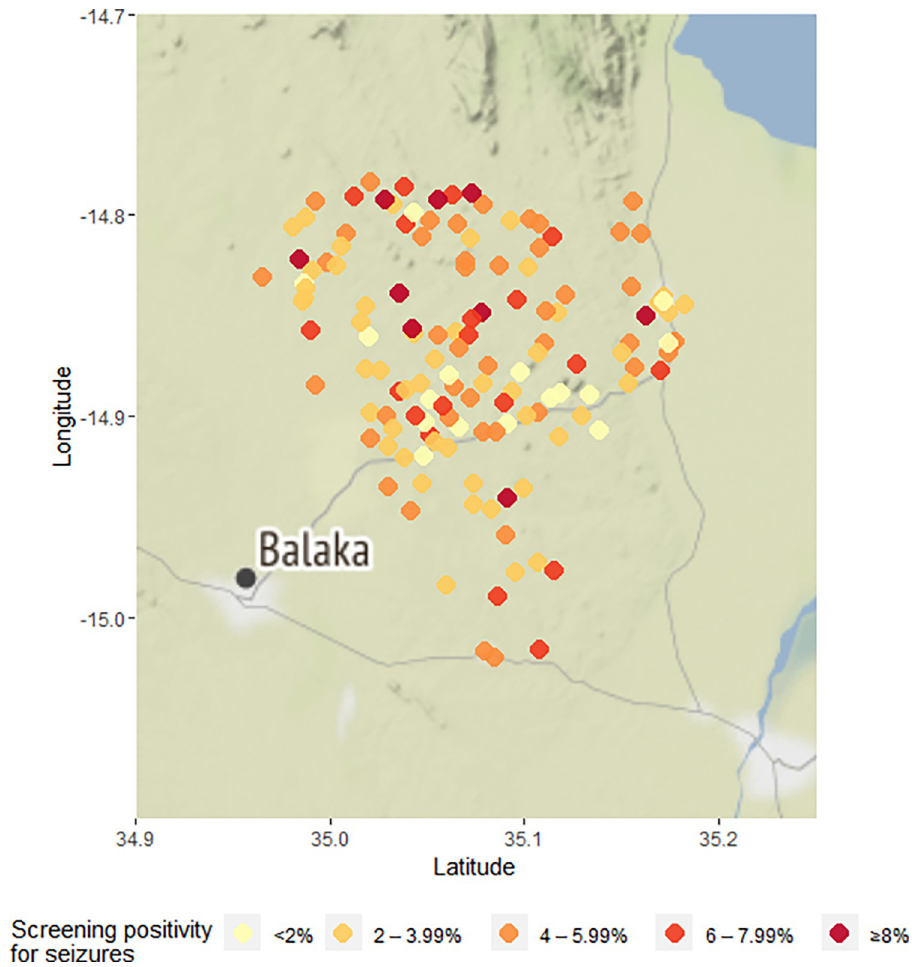
Fig 2. Villages by screening positivity for epilpetic seizures, Balaka district, Malawi.